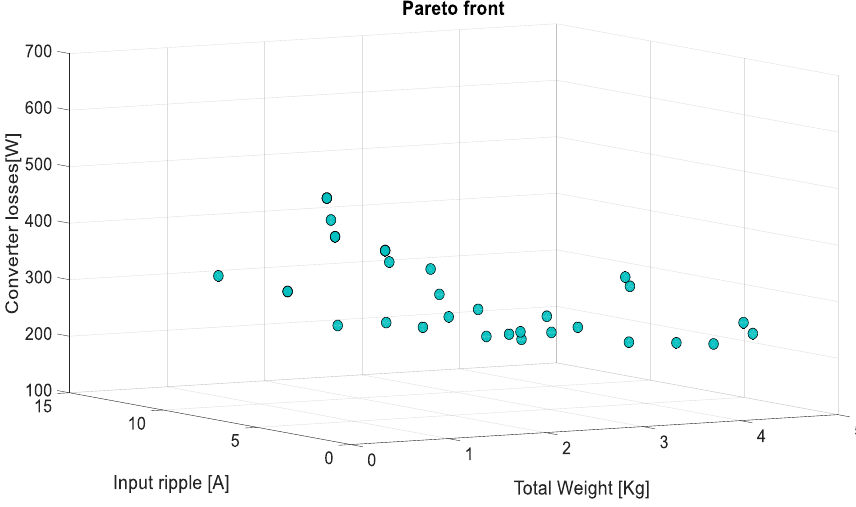
Figure 6. A three-dimensional Pareto optimal solution.